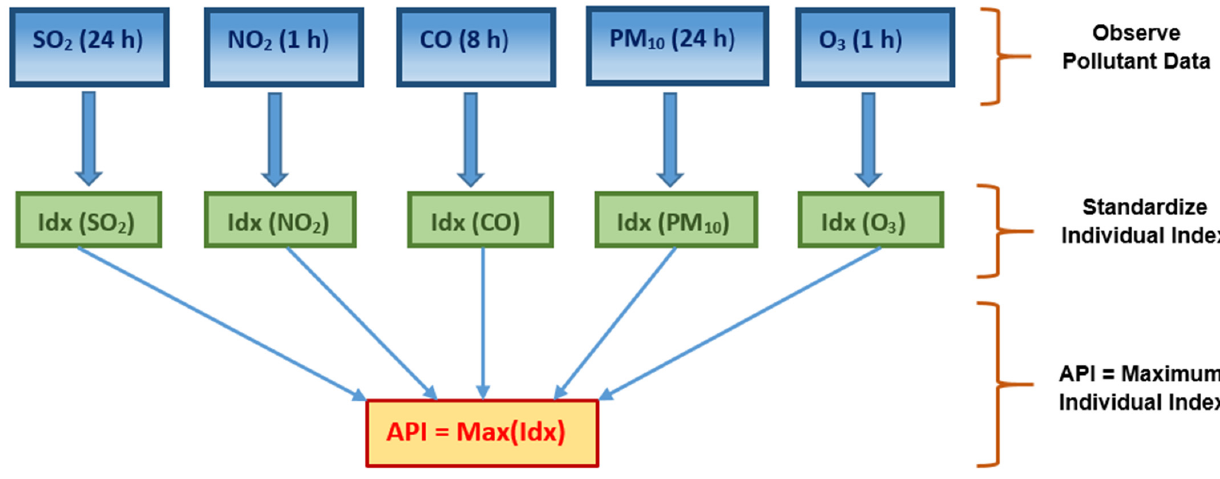
Figure 2. Process of determining the API value [53].